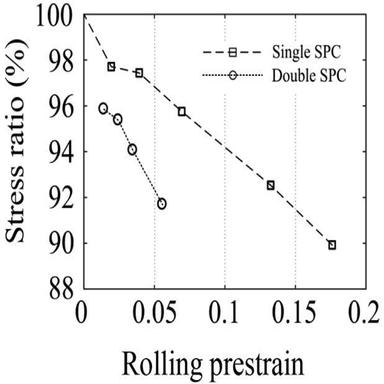
Stress ratio versus rolling prestrain at a total true plastic strain of 0.2 showing the degree of permanent softening. Results based on the rolling-tension tests in and the tension-rolling tension tests in are shown.